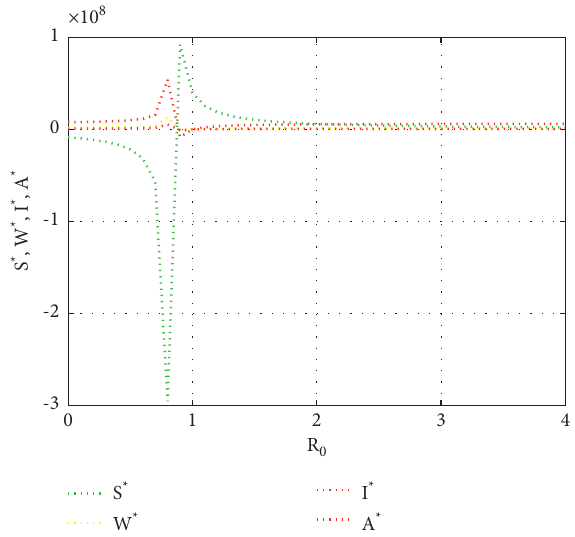
Figure 1: Simulation of the endemic equilibrium versus reproduction